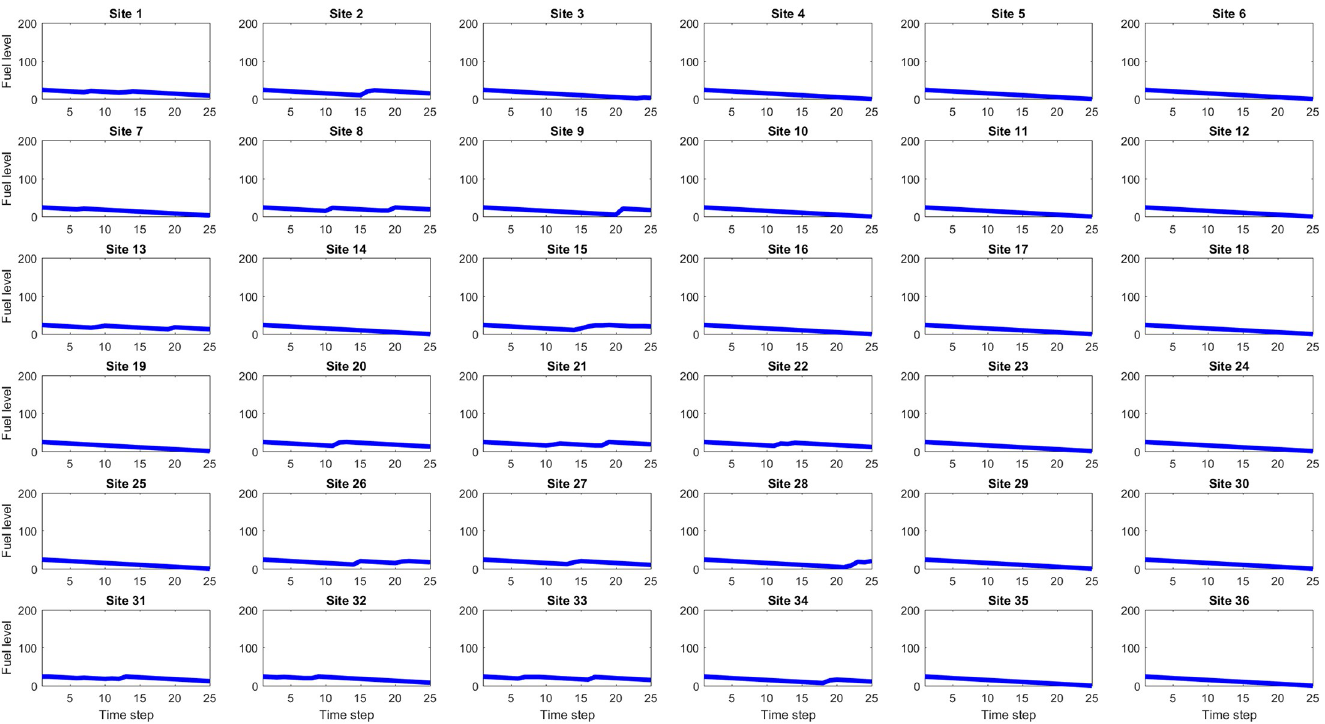
Fig 12. Time series of site fuel unit values, for 25 initial (and maximum) fuel units case. The linear decrease in fuel level is due to the consumption by each site of one fuel unit per time step in the simulation. The increases occasional increases in fuel level at some sites are due to refueling by mobile assets.